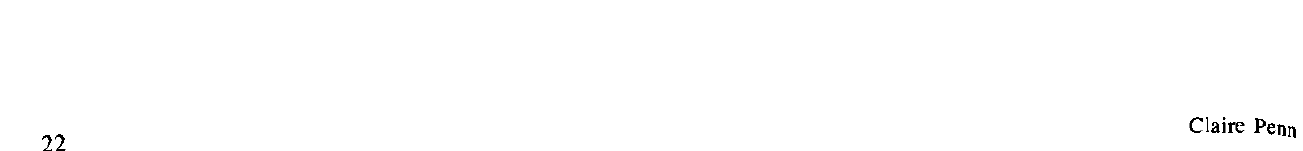
Figure 4 Clustering of the subjects on all Scales of PCA in relation to Appropriateness and severity